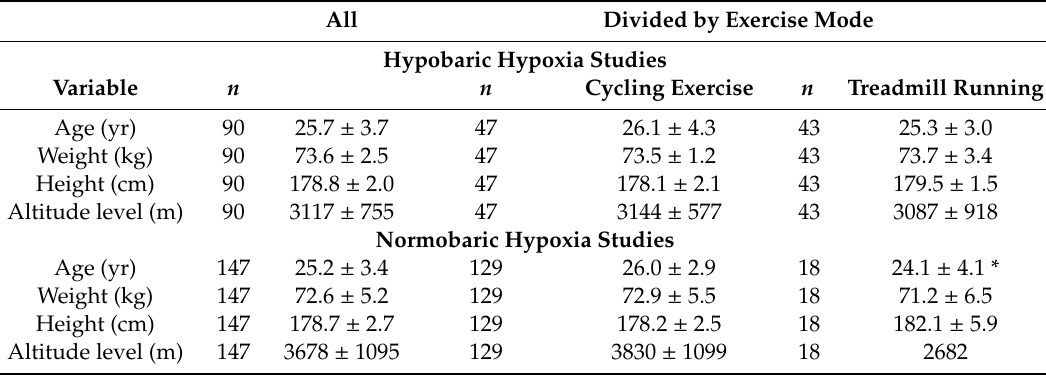
Table 2. Characteristics of study participants of the included HH and NH studies.